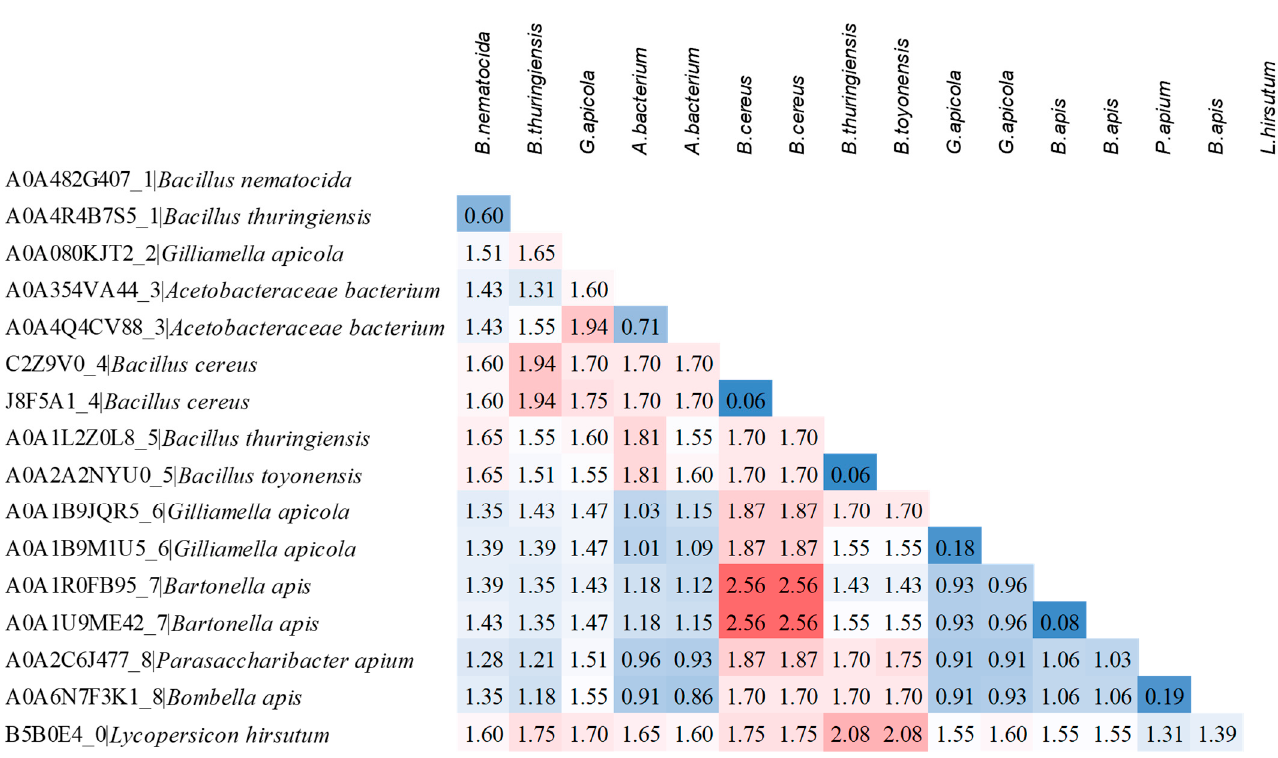
Figure 4. Estimates of the evolutionary divergences between a selection of representative protein sequences from each cluster. UniProt ID, cluster number and bacterial species are reported for each sequence. The number of amino acid substitutions per site from between sequences are shown. The values highlighted in blue indicate the most similar sequences, while those in red the most diverse.